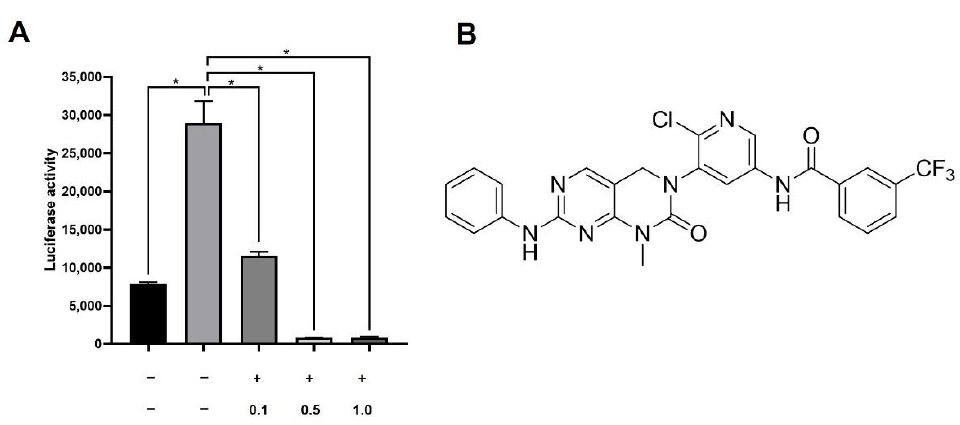
Figure 1. Derivation and structure of AX-0085. ( A ) Results from luciferase-based screen identifying AX-0085. Data are average of two independent experiments and error bars represent standard deviation (* p -value of < 0.05 from Student’s t -test). ( B ) Molecular structure of AX-0085.